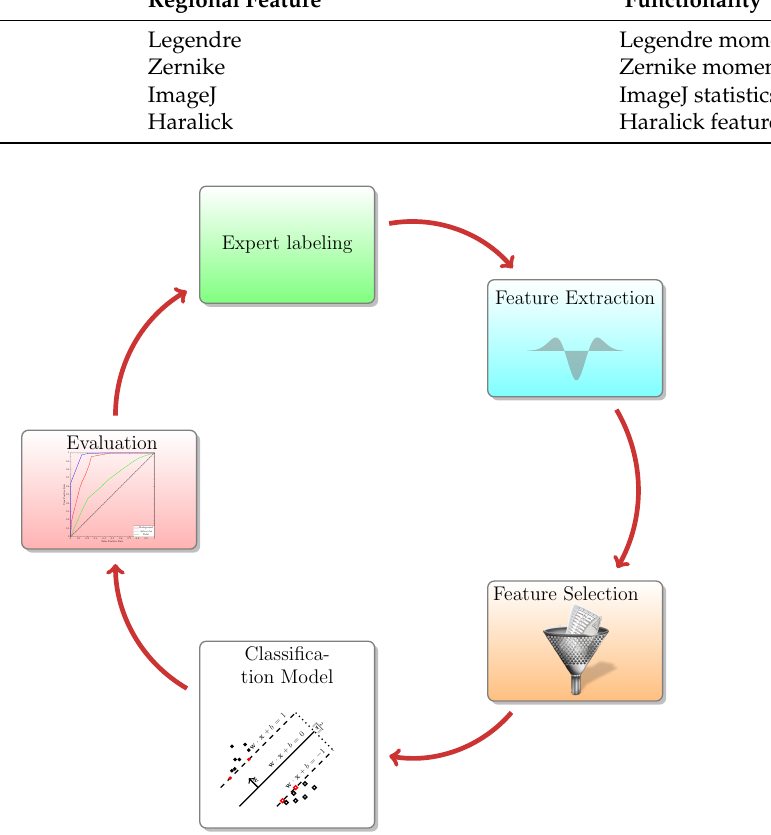
Figure 1. Learning cycle.